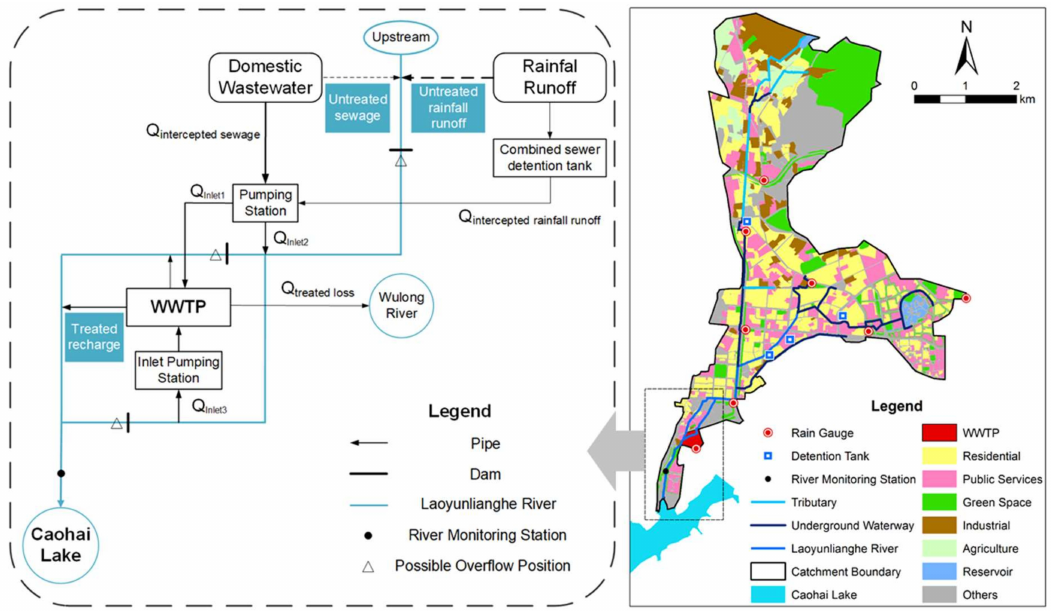
Figure 3. The urban-dominated land use patterns and complex river network of the Laoyunlianghe River catchment ( right ) with a focus on the drainage network of the lower catchment ( left ). The three major nutrient sources identified in this study are denoted by blue